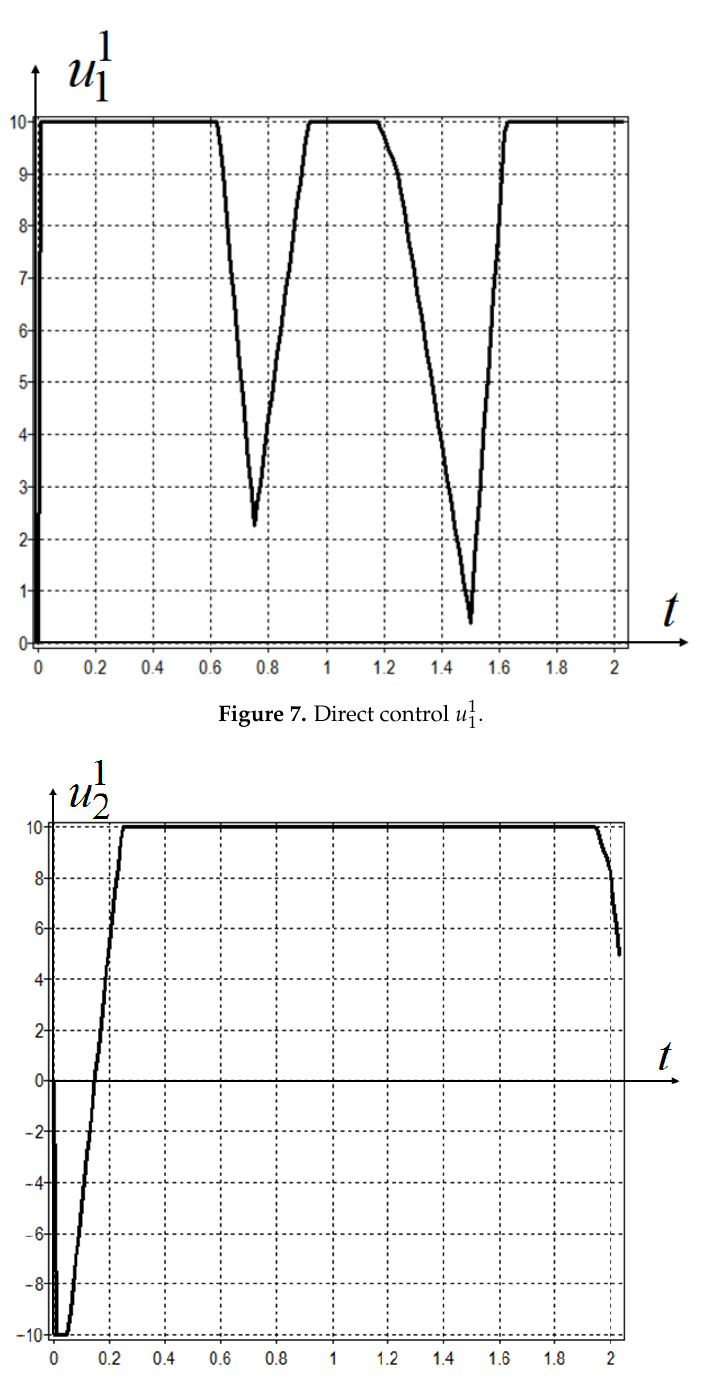
Figure 8. Direct control u 1